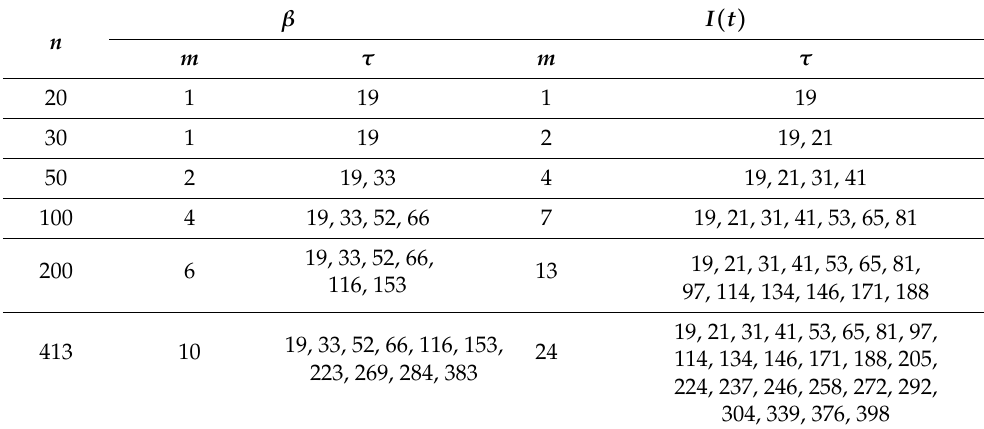
Table A8. BOCPD Algorithm Result for Poland’s COVID-19 Transmissibility Rate and Infection. β n